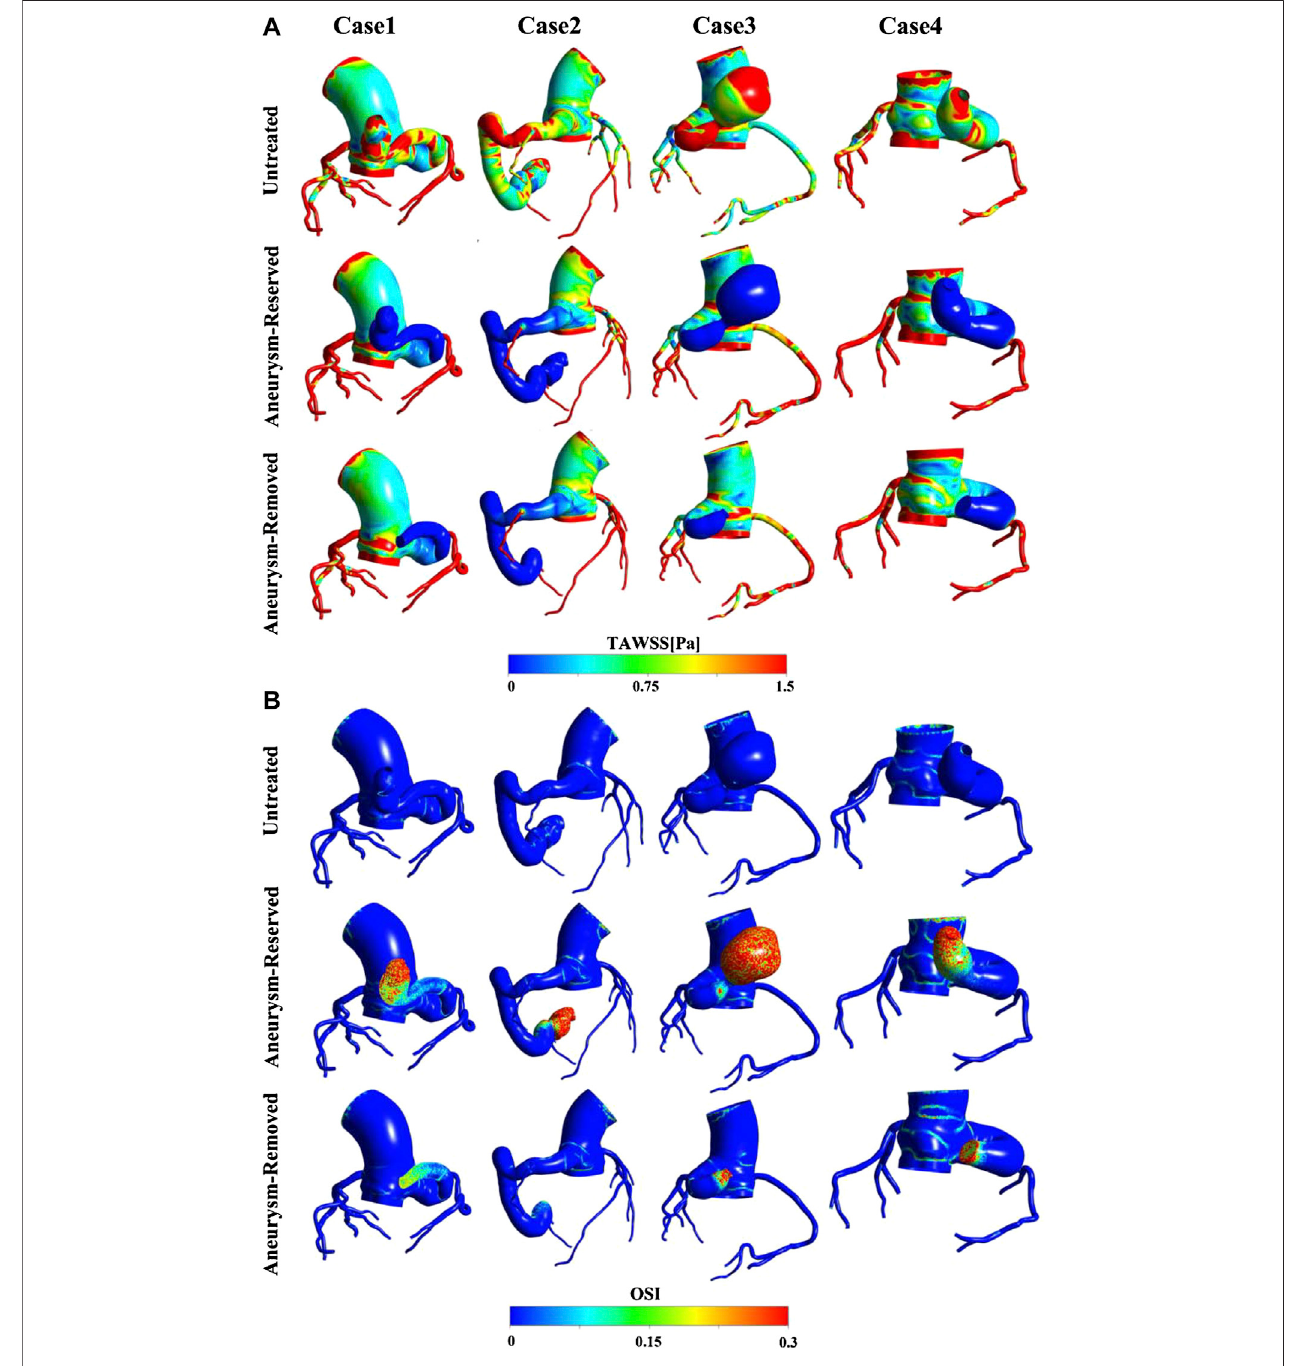
FIGURE 5 | (A) TAWSS contours; (B) OSI